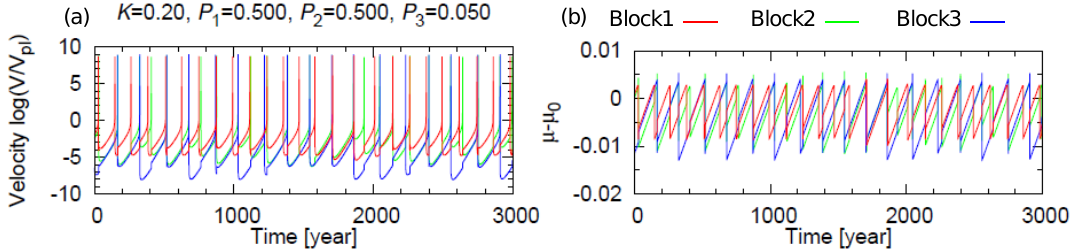
Figure 10. Example histories of (a) V and (b) µ − µ ∗ for pattern 3. The model parameters are set to K = 0 . 20, P 1 = 0 . 500, P 2 = 0 . 500, and P 3 = 0 . 050.